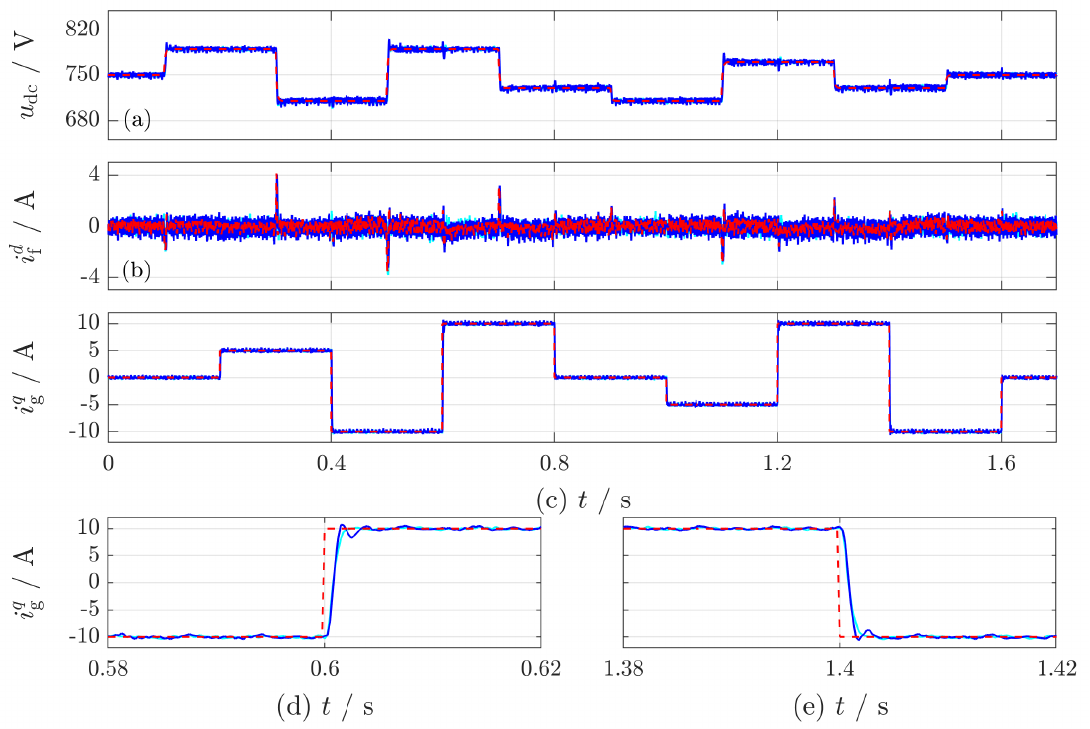
Figure 10. Experiment (E2)—Simulation and measurement results: ( a – c ) time sequences and comparisons of simulative and experimental results of all controlled states u dc , i d steps of the tracking control of i q g . [Color code: reference signal of measurement results, simulated actual value, measured actual value].